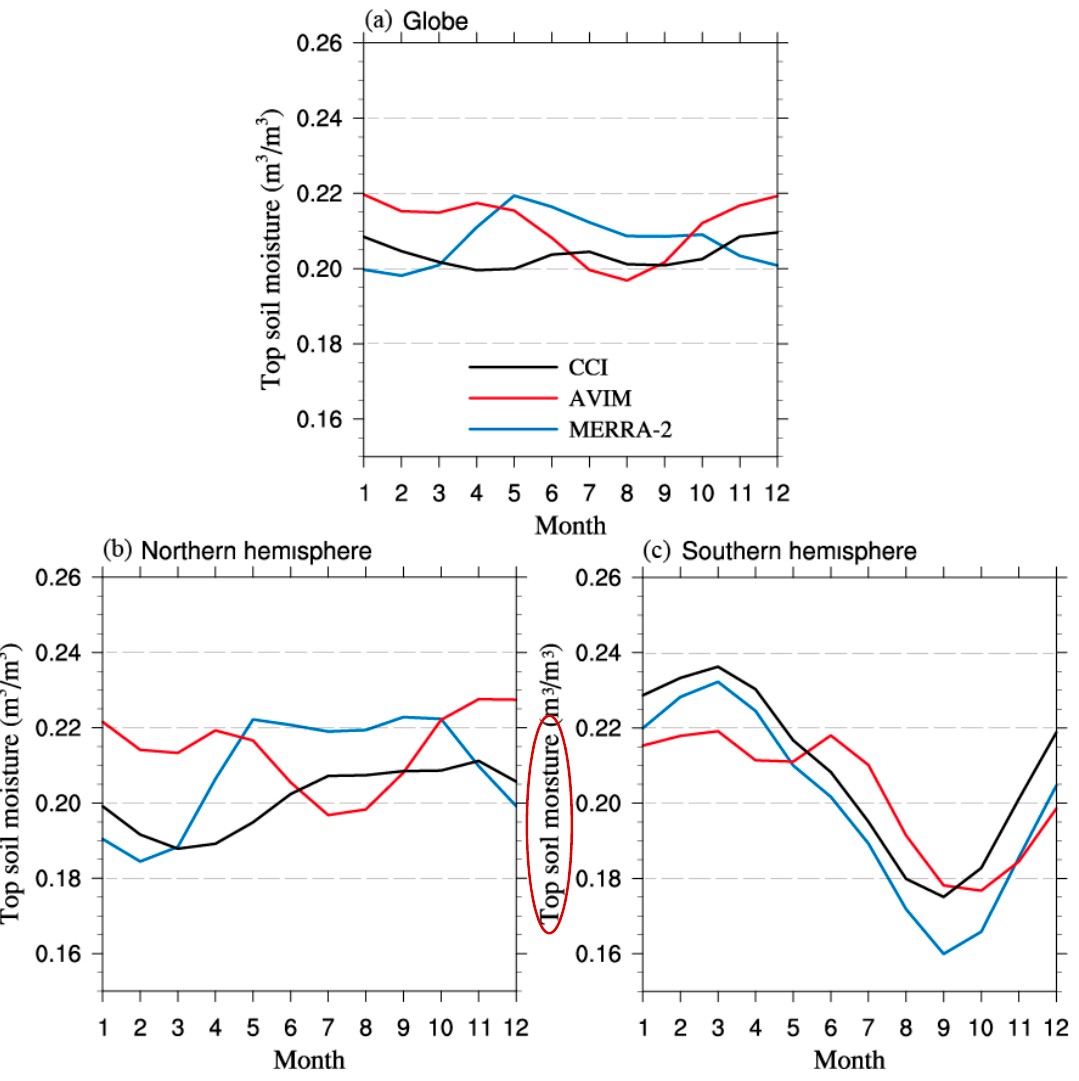
Figure 5. Annual cycle of the area-weighted mean surface soil moisture globally ( a ), in the Northern Hemisphere ( b ) and in the Southern Hemisphere ( c ) for the AVIM, MERRA-2, and CCI datasets.